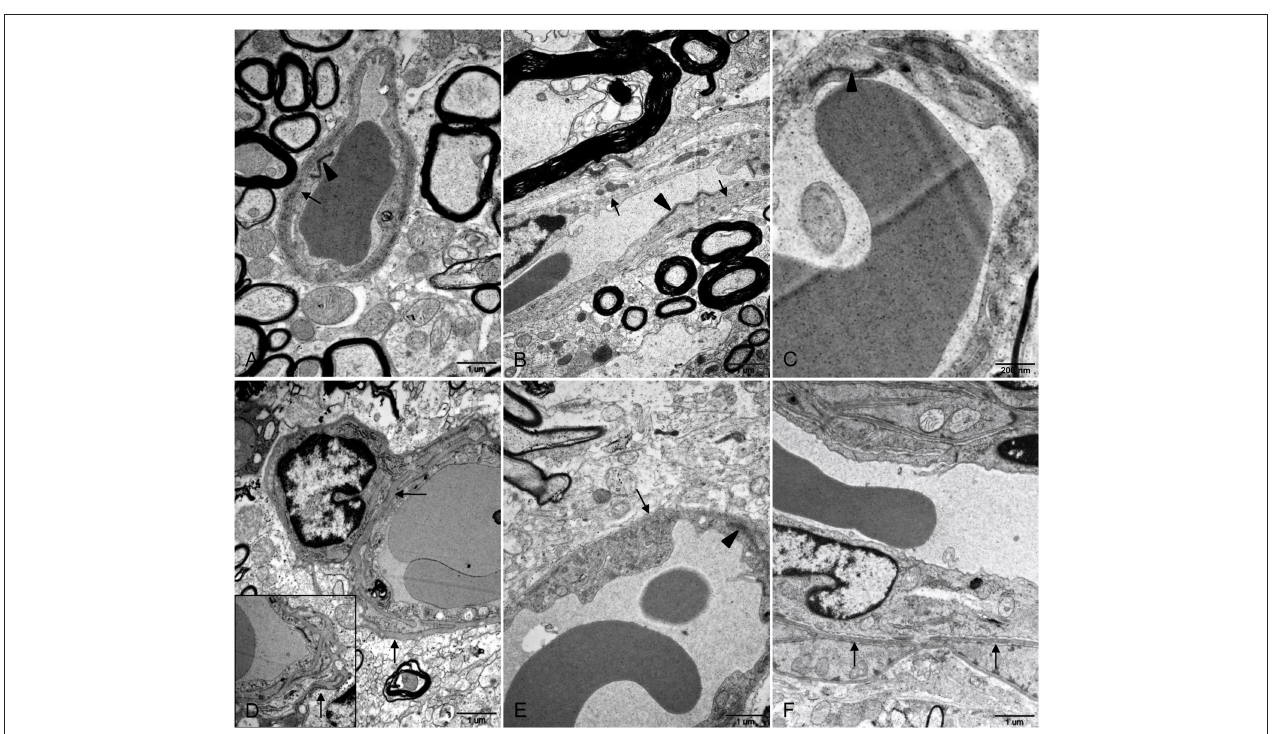
FIGURE 3 | Ultrastructural examination of BBB in brain and spinal cord tissues. (A–C) Basement membranes of blood vessel wall was intact and smooth (arrows) and junctional complexes between the endothelium were compact and clearly defined (arrowheads) in control brain (A) and spinal cord (B,C) tissues. (D–F) In brain tissues from HEV RNA-positive gerbils, basement membranes of capillary endothelium as well as pericytes was thickened and reduplicated (arrows) (D) . In spinal cord tissues positive with HEV RNA, basement membranes of blood vessel endothelium was irregular and thickened (arrows) (E,F) , and junctional complexes between endothelial cells were indistinct (arrowhead) (E)